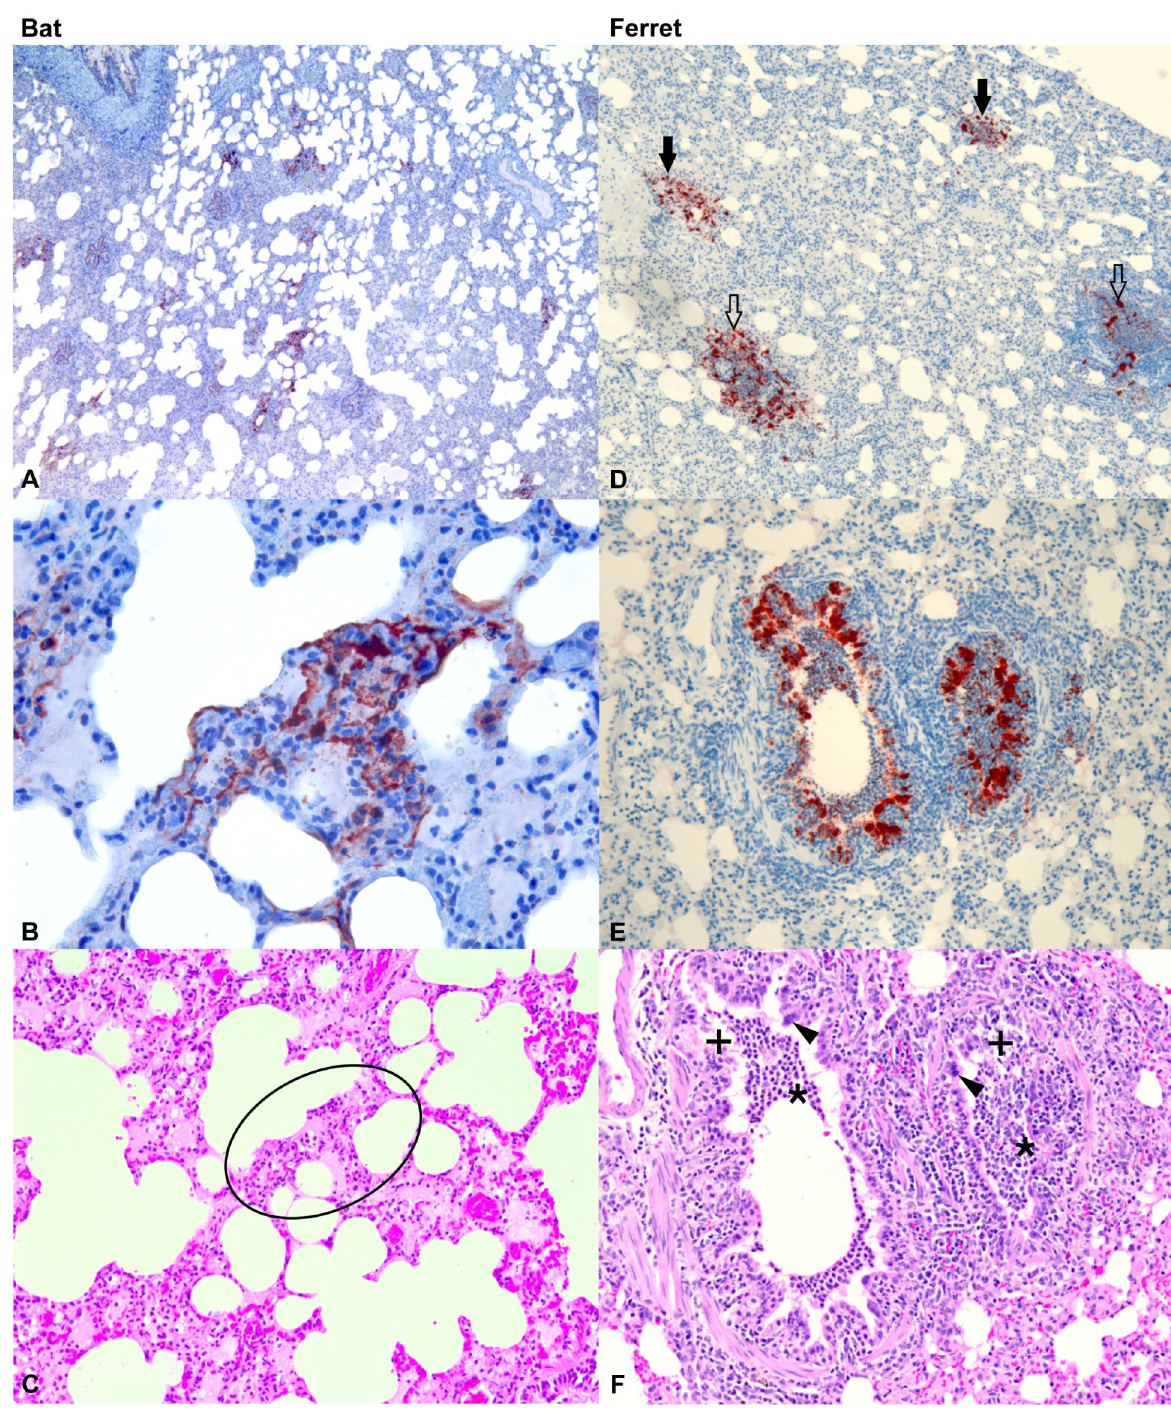
Fig 2. Histopathology of lung from infected bats and ferrets at 60 hpe. Immunohistochemistry for Hendra viral nucleoprotein (N) antigen (brick red colour) (A, B, D, E) and haematoxylin and eosin stain (C, F). ( A) Bat lung showing multiple foci of viral antigen in interstitium. ( B ) Bat lung at higher magnification showing detail of antigen localization in alveolar wall. ( C ) Bat lung of the same area as B (within ring) showing the absence of abnormalities. ( D ) Ferret lung showing viral antigen in interstitial foci (filled arrows) and in association with bronchioles (open arrows). ( E ) Ferret lung showing viral antigen in bronchiolar epithelium and luminal cell material. ( F ) Ferret lung of the same locality as E, showing epithelial cell degenerative changes (+) associated with antigen, neutrophil accumulation in the airway lumen ( � ) and syncytia of the epithelial cells (arrowheads). A, B, C: bat B8-60; D, E, F: ferret F8-60.